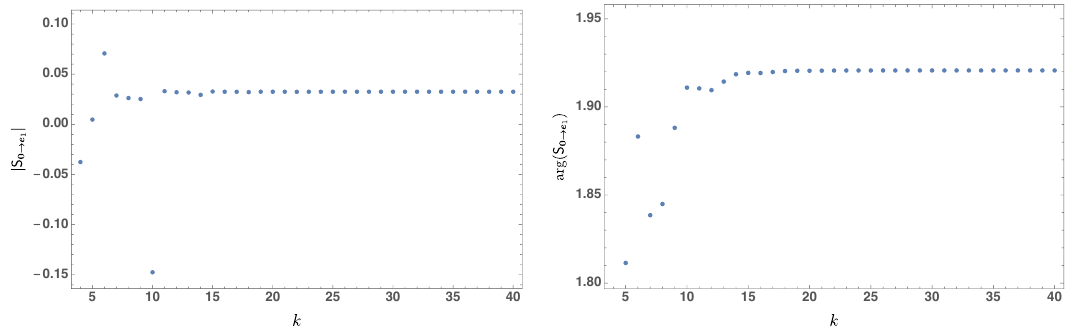
Figure 3 . The plots show the convergence of the modulus and argument of Stokes constant (or rather, the appropriate Borel residue). The quantities plotted are k -dependent, but the large-order relations imply that for large enough values of k they should saturate, approaching the values of the modulus and argument of the Stokes constant (for details see ref. [19]). We see that this happens already at moderate values of k . At k = 250 the variation is of order 10 (cid:0) 54 . easily be veri(cid:12)ed, leading to an accurate estimate of the Borel residue. The result of such a procedure | implementing precisely the techniques of ref. [19] but now using the series calculated for N = 4 SYM leads to the results shown in (cid:12)gure 3. This provides further support for our